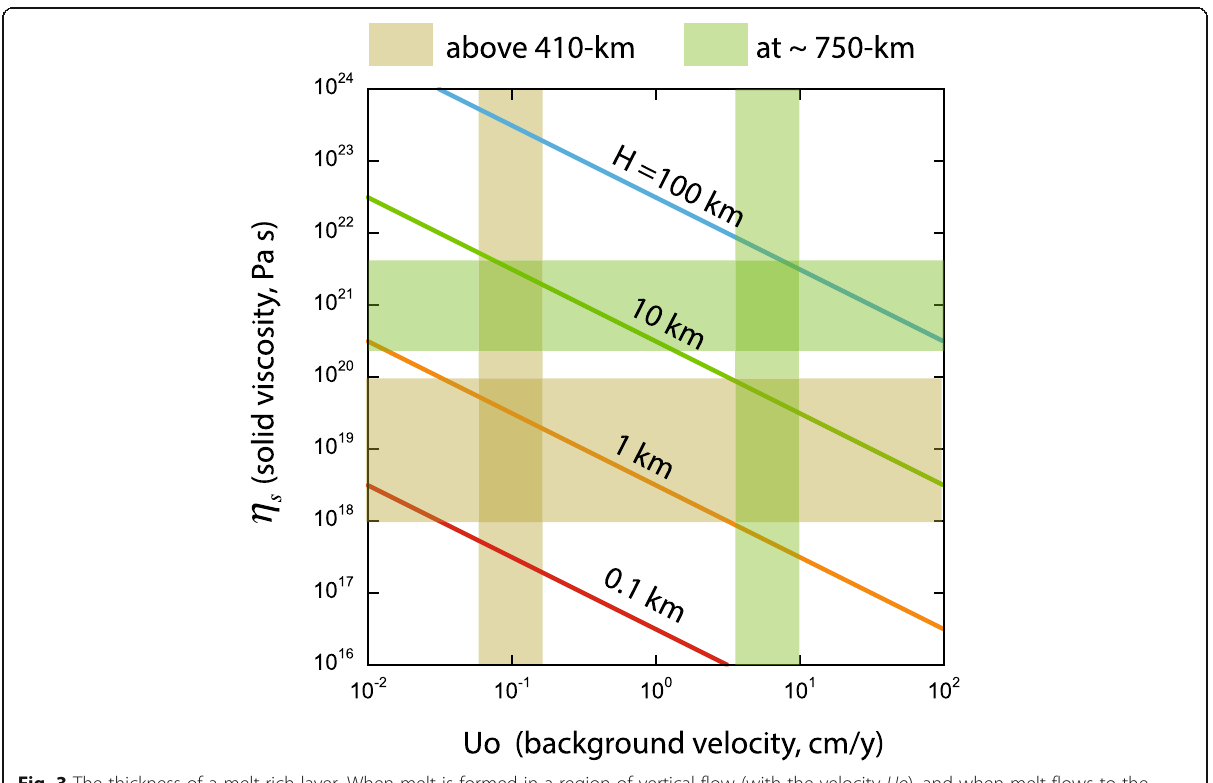
Fig. 3 The thickness of a melt-rich layer. When melt is formed in a region of vertical flow (with the velocity Uo ), and when melt flows to the opposite direction of the background flow as in the most case of partial melting across the MTZ, a melt-rich layer is formed near the region where melt is formed. The thickness of this layer, H , is given by H ≈ difference between the melt and the solids (~ 100 kg/m 3 ), g : acceleration due to gravity). Both Uo and η S are markedly different between the melt-rich layer above and below the MTZ leading to largely different values of